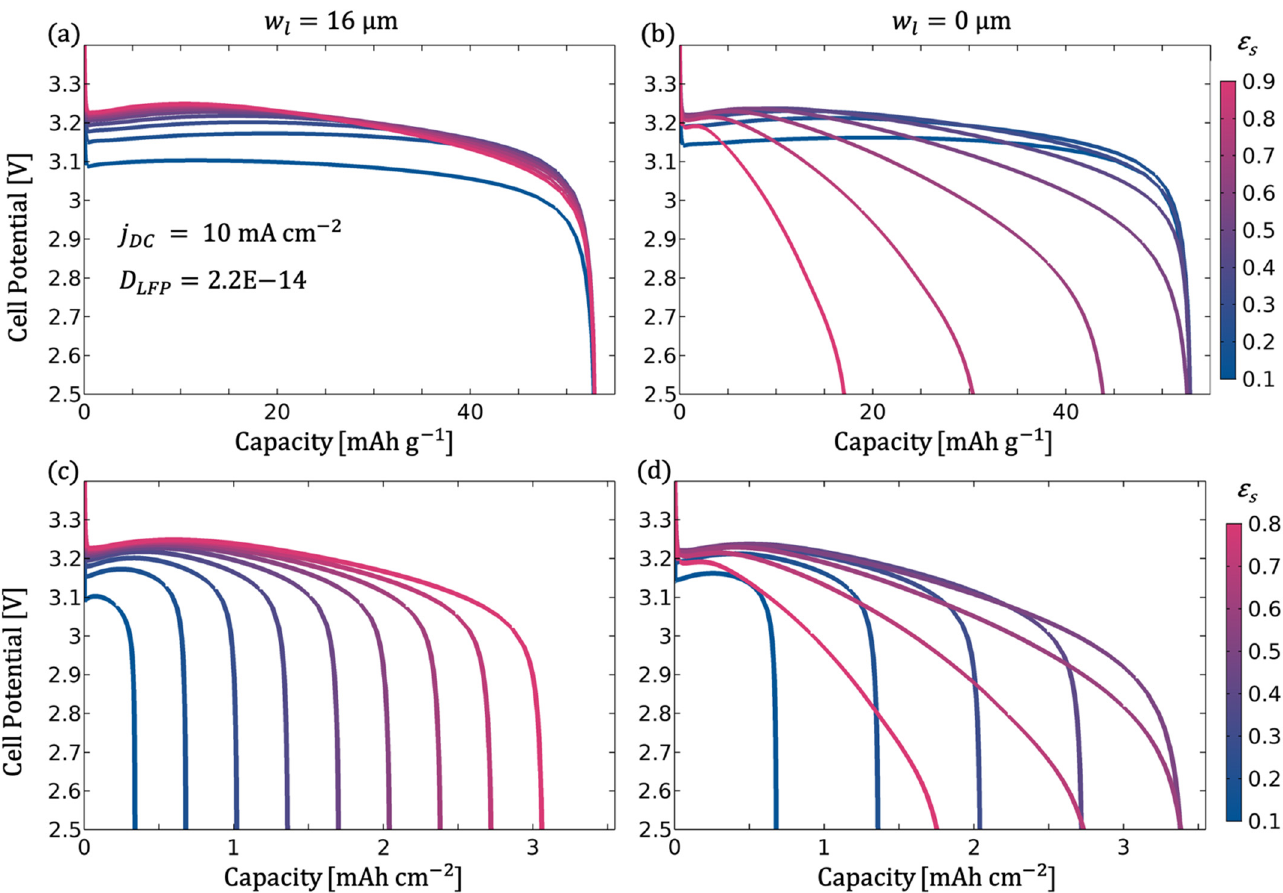
Figure 16. Discharge performance at a constant current density of j DC = 10 mA cm − 2 at D LFP = 2.2 × 10 − 14 for the lamella structure ( a , c ) and for the single structure ( b , d ) (see Figure 2) . In ( c , d ), the capacity is related to the current collector area and in ( a , b ) to the active mass .